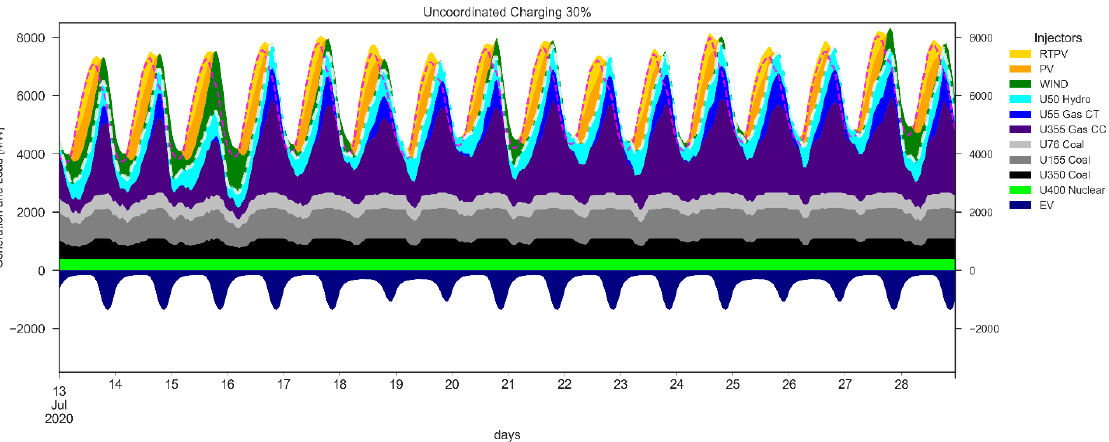
Figure 14. The generation stack for peak weeks in July, assuming 30% EV penetration and uncoor- dinated EV charging.